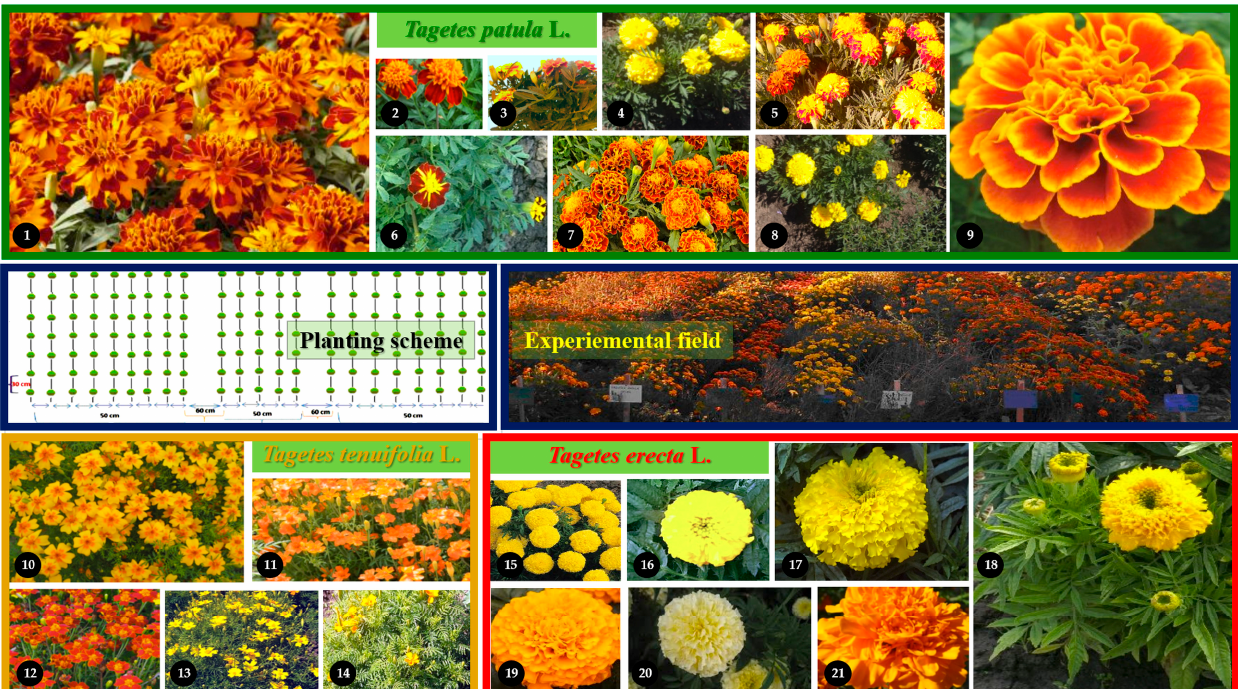
Figure 10. Planting scheme, experimental field and analysed cultivars belonging to three species of Tagetes : T. patula (1—Bolero, 2—Orange Flame, 3—Szinkeverek, 4—Robuszta, 5—Orion, 6—Mr. Majestic, 7—Cresto Flame, 8—Cresto Yellow, 9—Queen Sophia), T. tenuifolia (10—Luna Gold, 1—Luna Orange, 12—Luna Rot, 13—Luna Lemon, 14—Sarga) and T. erecta (15—Aranysarga, 16—Alacsony Citromsarga, 17—Magas Citromsarga, 18—Cupid Golden Yellow, 19—Antigua Orange, 20—Artic, 21—Hawaii).